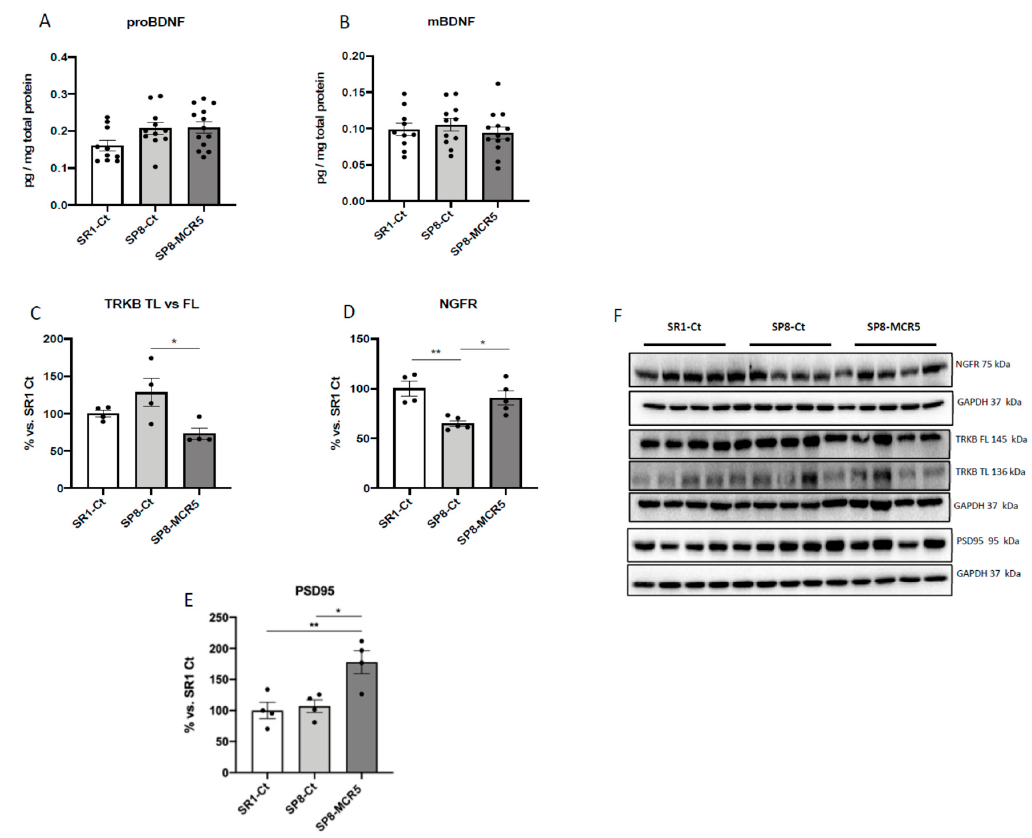
Figure 7. Protein levels of proBDNF ( A ), and mBDNF ( B ). Representative Western Blot and quantifications for ratio TrkB-TL vs. TrkB-FL, NGFR, and PSD95 ( C – F ). Values represented are mean ± Standard error of the mean (SEM); ( n = 4–13 for each group). * p < 0.05; ** p < 0.01.